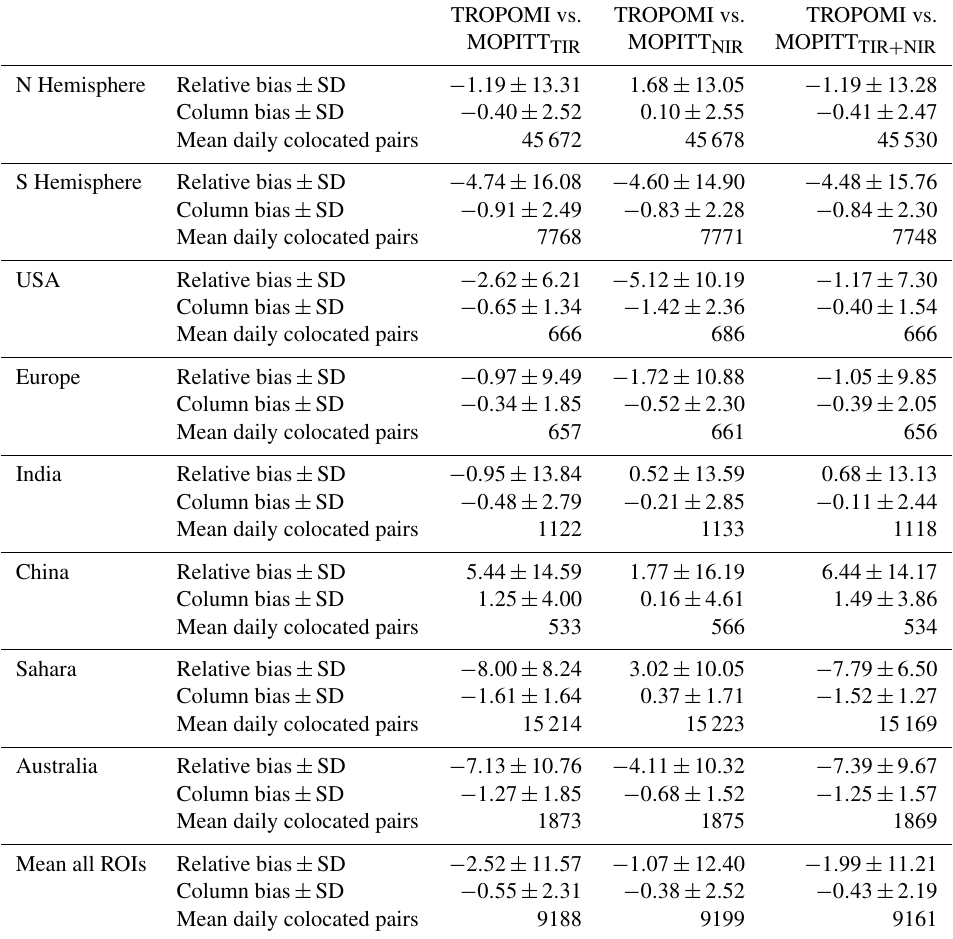
Table 4. Statistics from colocated, null-space-adjusted TROPOMI vs. MOPITT CO retrievals over land for the period between 7 Novem- ber 2017 and 10 March 2019. Relative bias and SD are in percent. Column bias and SD are in units of 10 17 moleccm − 2